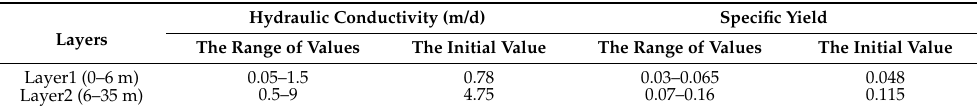
Table 1. The initial values of the hydraulic conductivity and specific yield in the model. Hydraulic Conductivity (m/d) Specific Yield Layers The Range of Values The Initial Value The Range of Values The Initial Value Layer1 (0–6 m) 0.05–1.5 0.78 0.03–0.065 0.048 Layer2 (6–35 m) 0.5–9 4.75 0.07–0.16